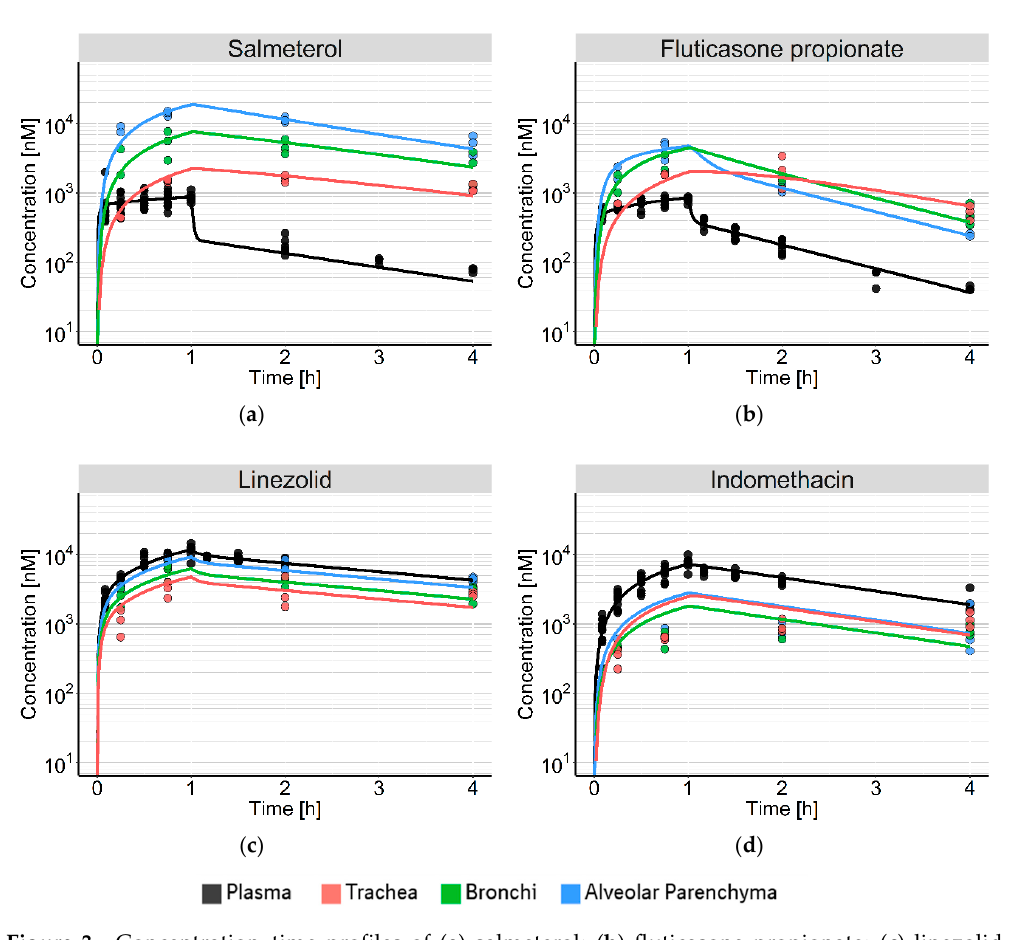
Figure 3. Concentration–time profiles of ( a ) salmeterol; ( b ) fluticasone propionate; ( c ) linezolid, and ( d ) indomethacin. Dots represent the observed concentrations; solid lines show the model-based prediction. Plasma concentrations are shown in black; concentrations in the trachea, bronchi, and alveolar parenchyma are shown in red, green and blue, respectively.